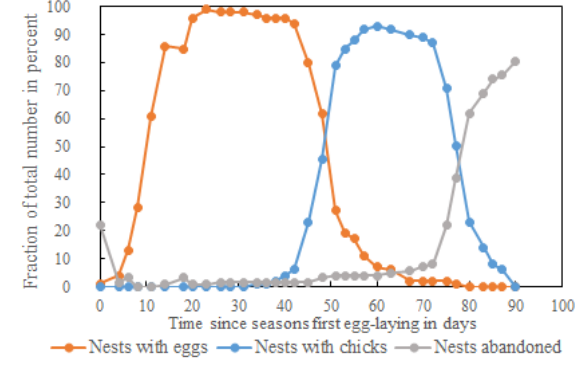
Figure 11. Season 2017/18: breeding phenology of gentoo penguins